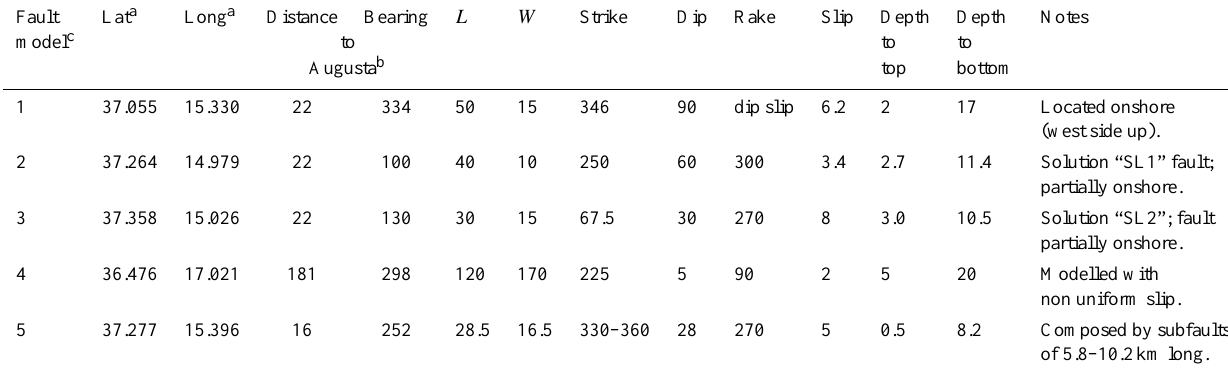
Table B1. Summary of various solutions for the source of the 11 January 1693 tsunami. Fault Lat a Long a Distance Bearing L W Strike Dip Rake Slip Depth Depth Notes model c to to to Augusta b top